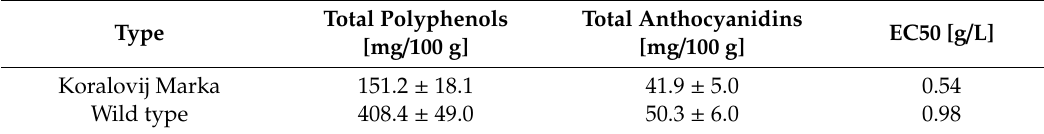
Table 1. Determination of anthocyanins, total polyphenols and EC50 DPPH in stoned fruit.